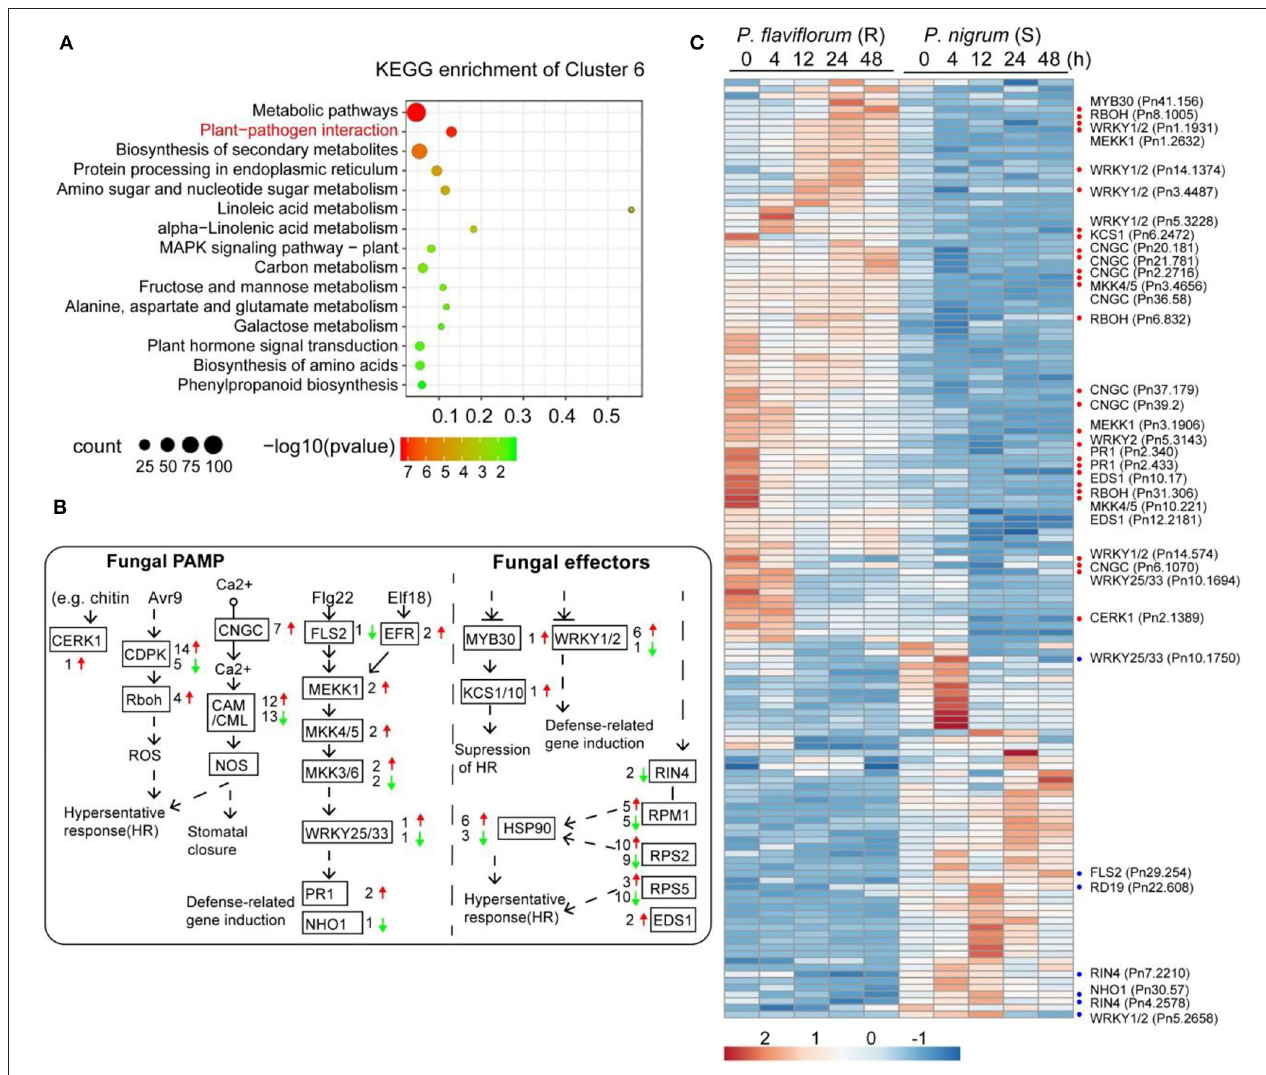
FIGURE 2 | Profiles of differentially expressed genes in the plant-pathogen interaction pathway. (A) KEGG pathway enrichment analysis of genes in cluster 6 from Figure 1 revealed genes higher-expressed in resistant Piper ( P. flaviflorum ) to be significantly enriched in plant-pathogen interaction pathway members. (B) The KEGG plant-pathogen interaction pathway map, annotated with differentially expressed genes. Red arrows indicate higher and green arrows indicate lower expression in resistant Piper ; numbers indicate the number of putative genes with differential expression. (C) Heatmap of the differentially expressed genes from panel b. For the detailed gene list, refer to Supplementary Table S2